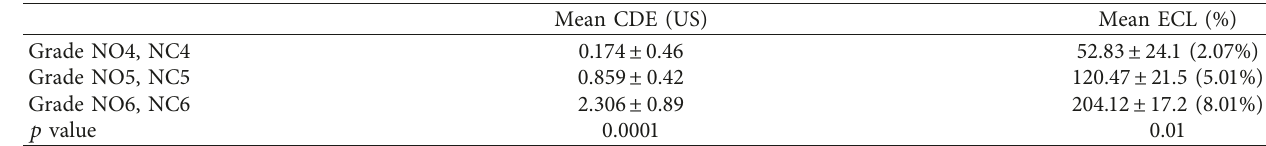
Table 3: The correlation between different cataract grades, mean CDE, and mean ECL.